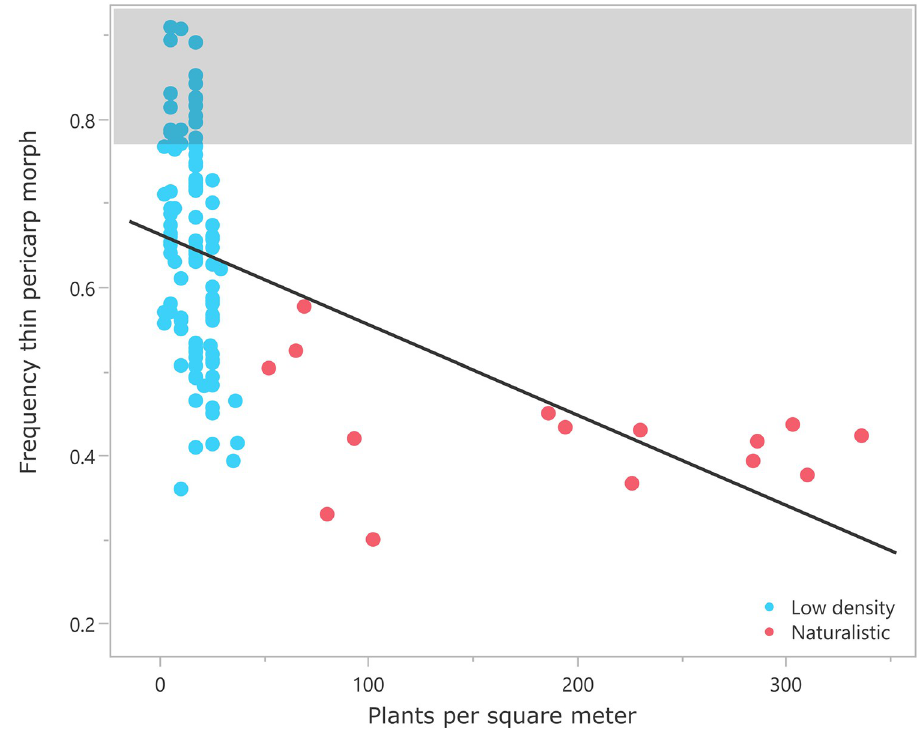
Fig 5. Correlation between the percent thin pericarp morphs in the harvest and plant density with line of best fit. Points within the shaded area are outside the range of variation documented for free-living erect knotweed.